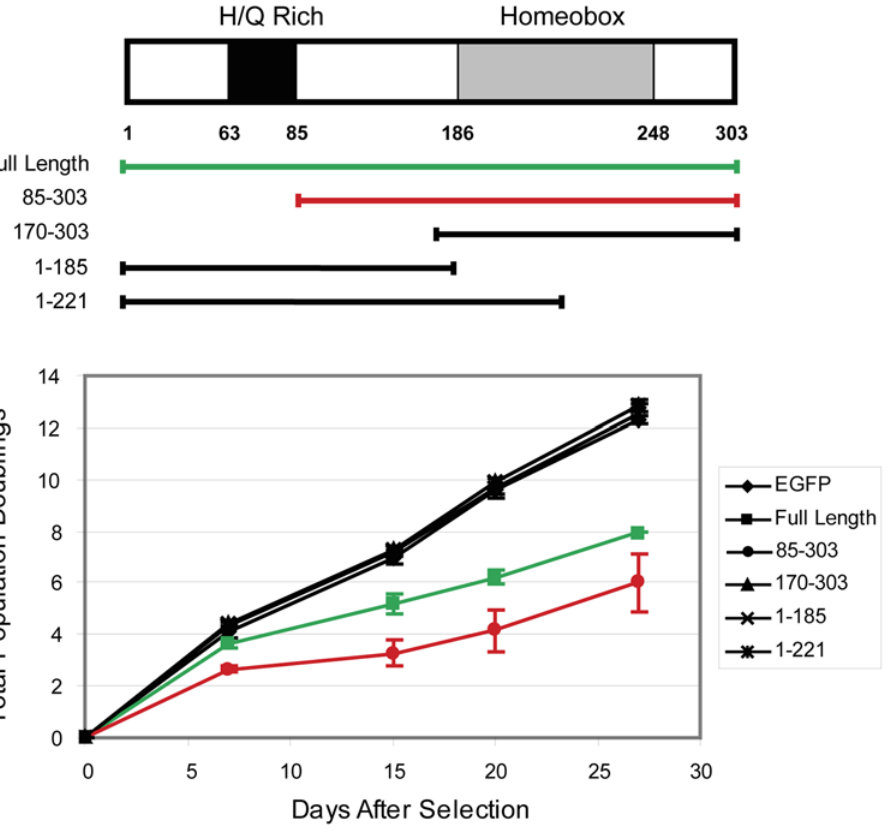
Figure 6. Structure/function analysis of the histidine/glutamine (H/Q) rich and homeobox domains of MEOX2. Retroviral constructs expressing the fragments of MEOX2 indicated by bars in the schematic (top panel) were assessed for induction of senescence as in Fig. 4. Results of three independent infections are depicted as mean values; error bars represent one standard deviation. Senescence-inducing constructs are shown in color.